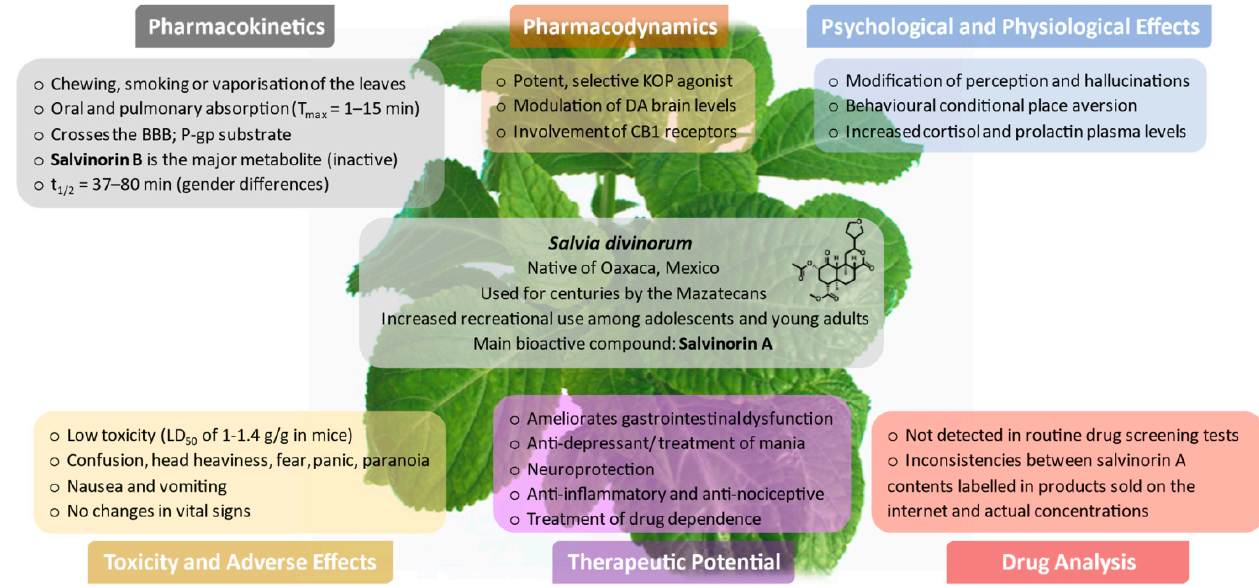
Figure 6. Toxicokinetic and toxicodynamic aspects of Salvia divinorum and salvinorin A. BBB: Blood–brain barrier; CB1: Cannabinoid receptor 1; DA: Dopamine; KOP: κ -Opioid receptor; P-gp: